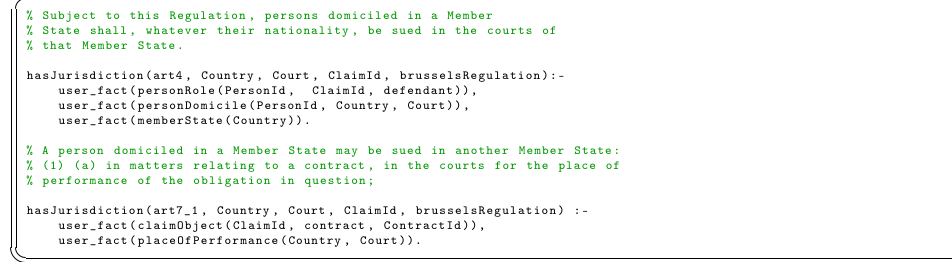
Figure 11. Brussels Regulation Prolog transposition.